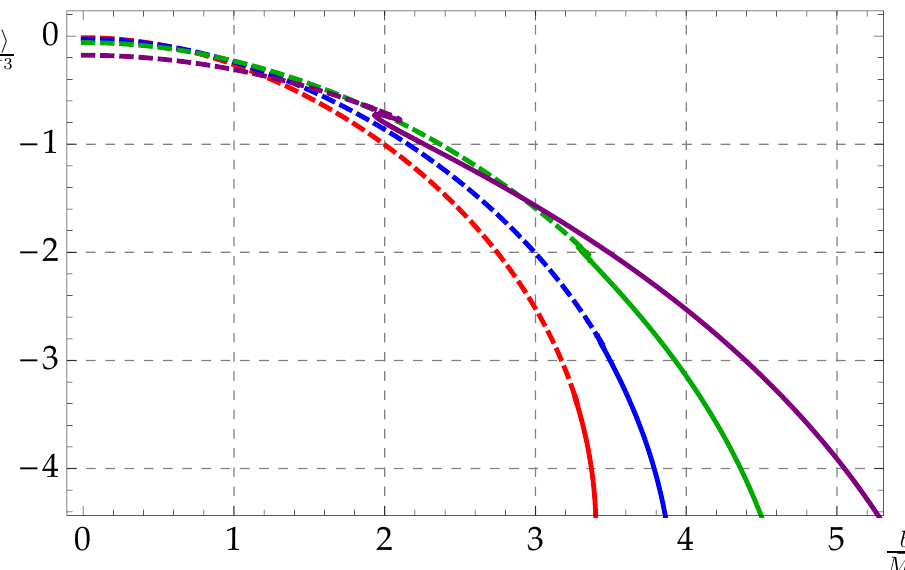
Figure 5 . Quark condensate h (cid:22) qq i =(cid:20) as a function of b= (cid:22) M 2 . Red, purple, green, and blue curves (left to right at the bottom) correspond to T= (cid:22) M = f 0 : 55 ; 0 : 59 ; 0 : 65 ; 0 : 734 g respectively. The dashed segments correspond to Minkowski embeddings, while the continuous segments correspond to black hole embeddings.